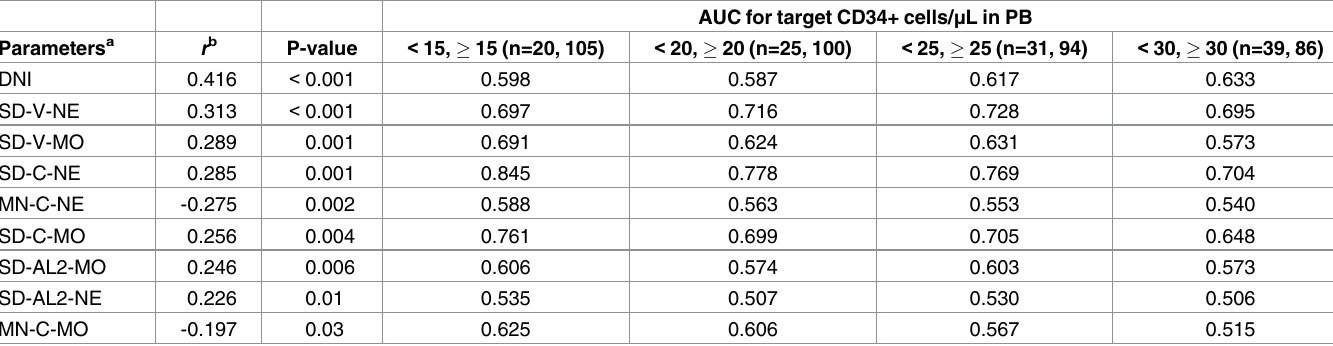
Table 1. Receiveroperating characteristics analysis using cell morphology parametersfor prediction of the CD34+ cell count. AUC for target CD34+ cells/ μ L in